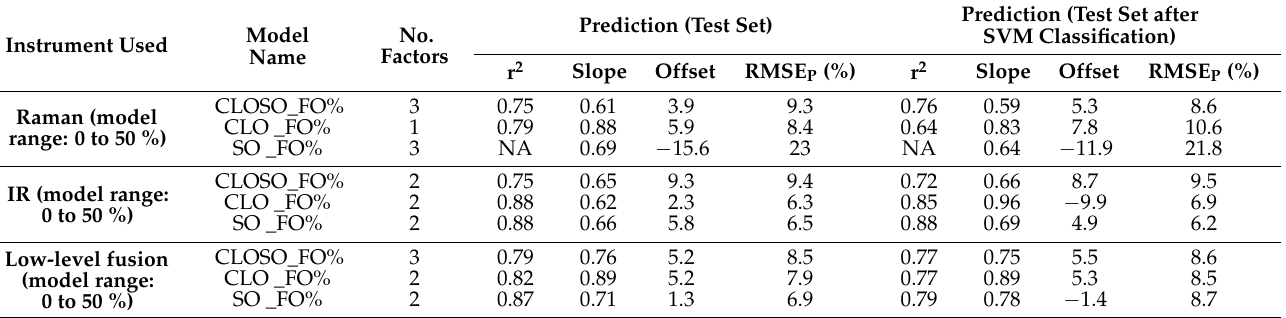
Table 4. Test set performance for the PLSR-based quantitative assessment of FO adulteration in CLO and